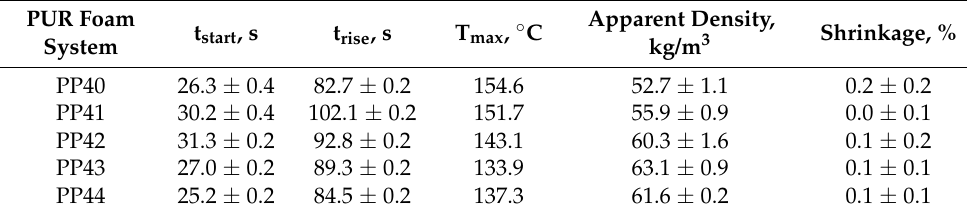
Table 3. Parameters of foaming processes of PUR systems PP40-PP44 (data from